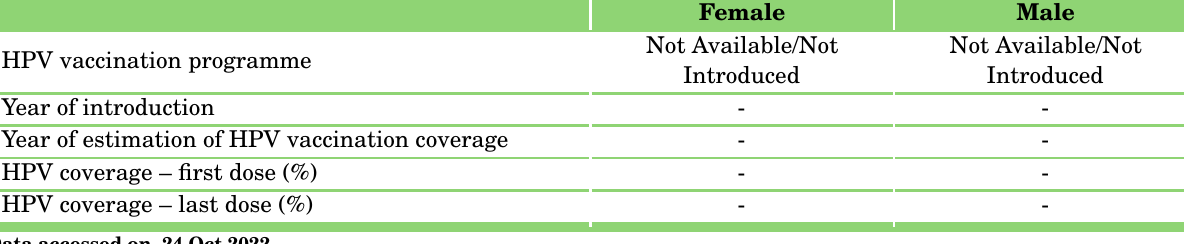
Table 46: National HPV Immunization programme in India